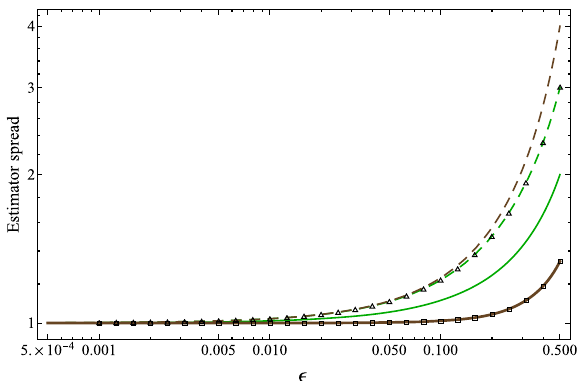
Fig. 6 The estimator spreads to mitigate global depolarizing noise on a 50-qubit system. Green curves: Δ e max for probabilistic error cancellation (dashed) and the lower bound for unbiased (1, 1)- mitigation protocols (solid). Brown curves: Δ e A with A ¼ 1 2-copy virtual distillation with GHZ state inputs (dashed) and the lower bound for (2, 1)-mitigation protocols with the same bias (solid). Triangles and rectangles: Δ e A with A ¼ 1 noise extrapolation (triangles) and a lower bound for (1, 2)- mitigation protocols with the same bias